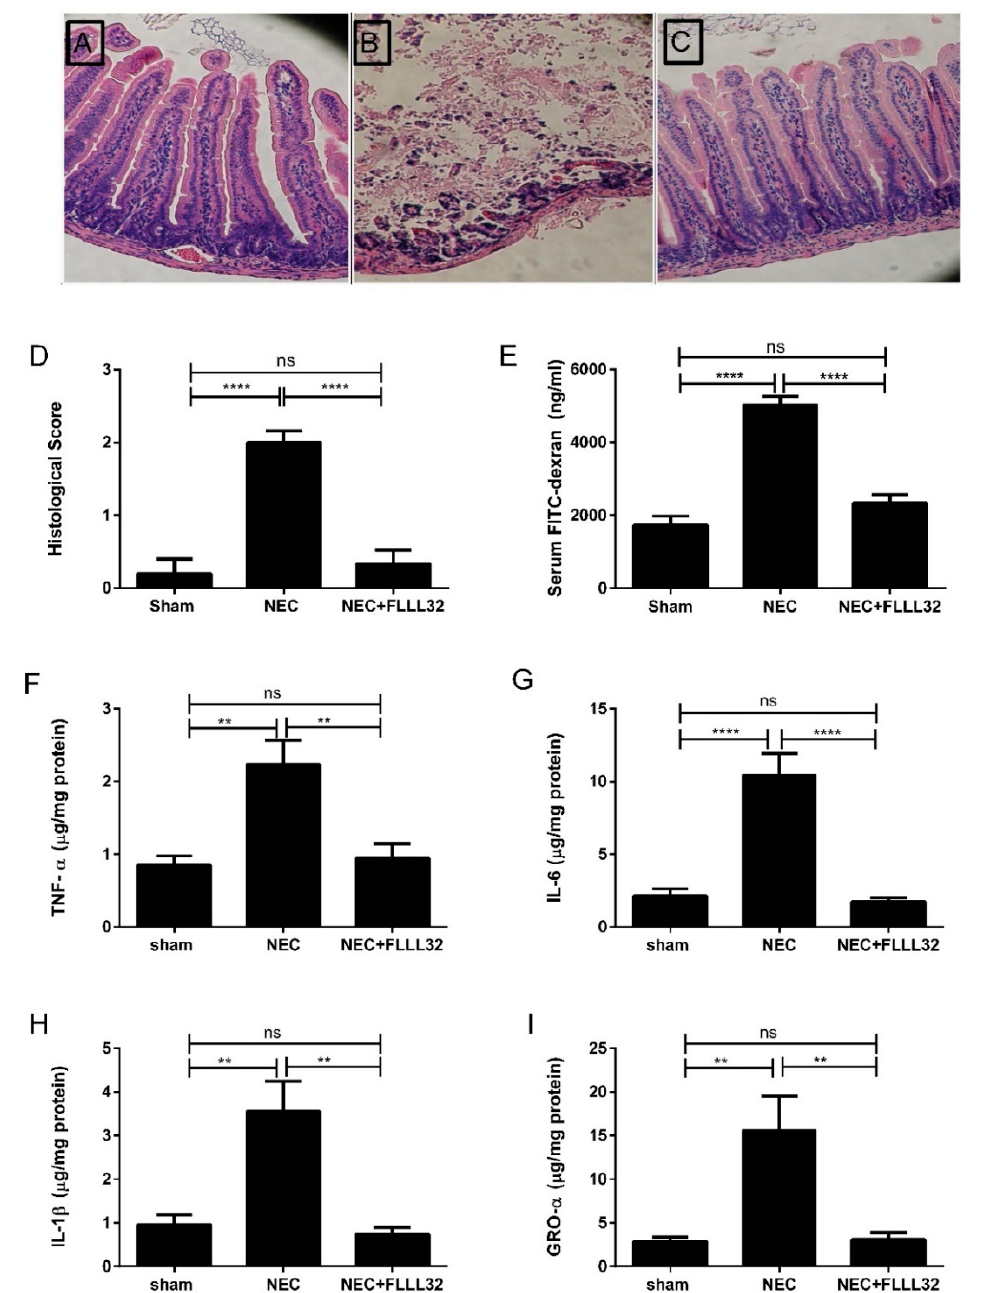
Figure 3. (Reprinted with permission from Dove Medical Press, Ltd.). FLLL32 attenuates intestinal inflammation and injury in DK NEC model. Representative H&E pictures from pups in the sham group ( A ), untreated NEC group ( B ), and NEC + FLLL32 group ( C ) (20 × magnification). ( D ) Histological NEC scoring was obtained by two pathologists blinded to the groups (**** p < 0.0001). ( E ) FLLL32 preserved intestinal permeability in the NEC + FLLL32 group compared to the untreated group and control group (**** p < 0.0001). FLLL32 pretreatment reduced the levels of proinflammatory cytokines, TNF- α ( F , p = 0.001), IL-6 ( G , p < 0.001), IL-1 β ( H , p = 0.009), and GRO- α levels ( I , p = 0.034) compared to pups in the untreated NEC group. Data are mean ± SEM. Results are representative of at least three separate experiments.